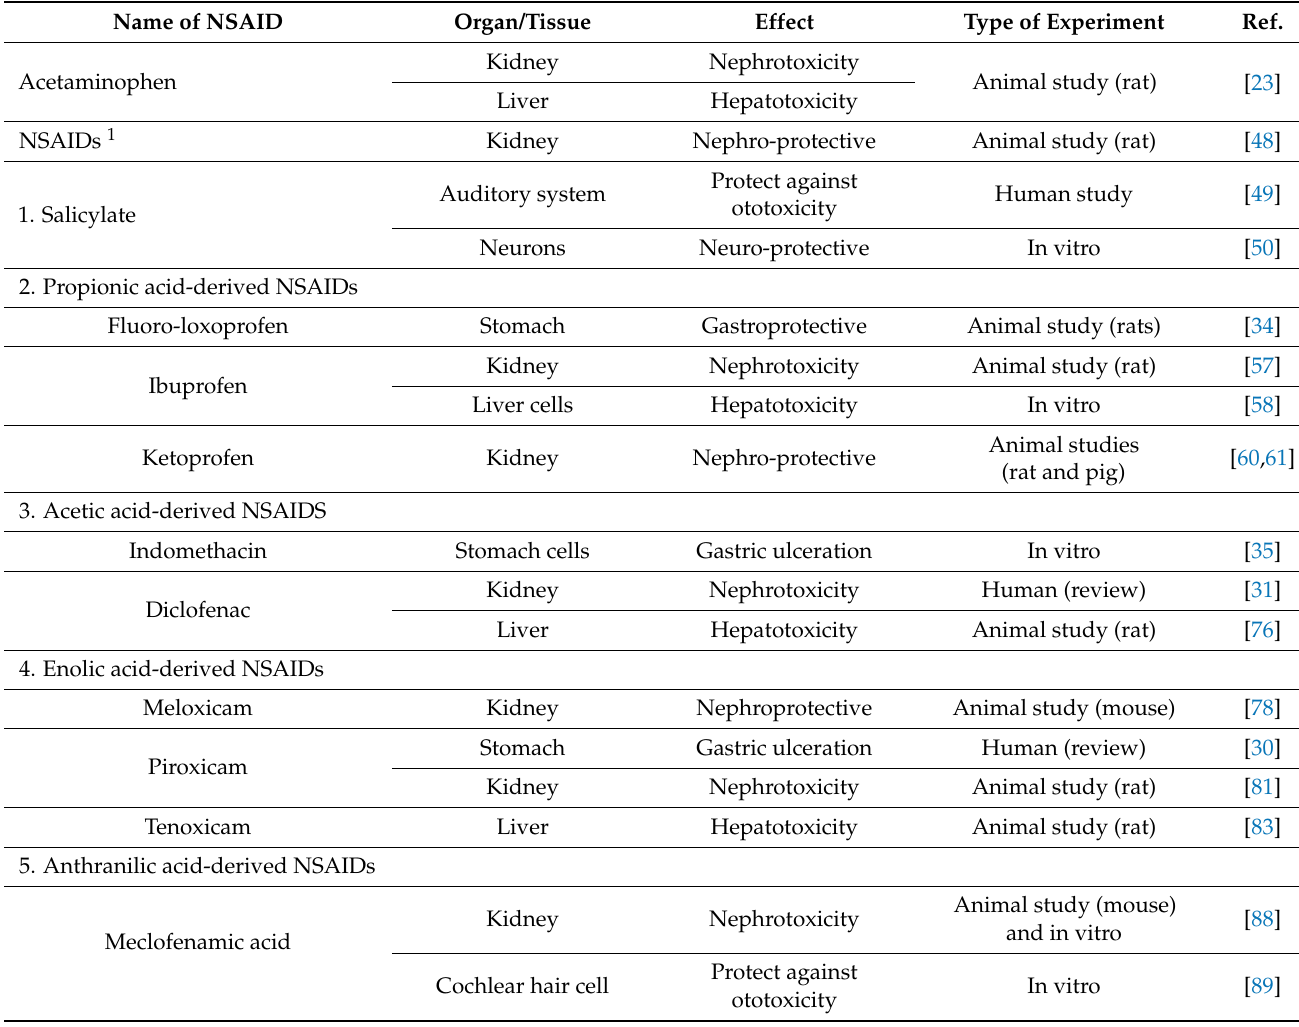
Table 1. Effect of analgesics on organ toxicity that may deteriorate or protect against cisplatin-induced organ/tissue